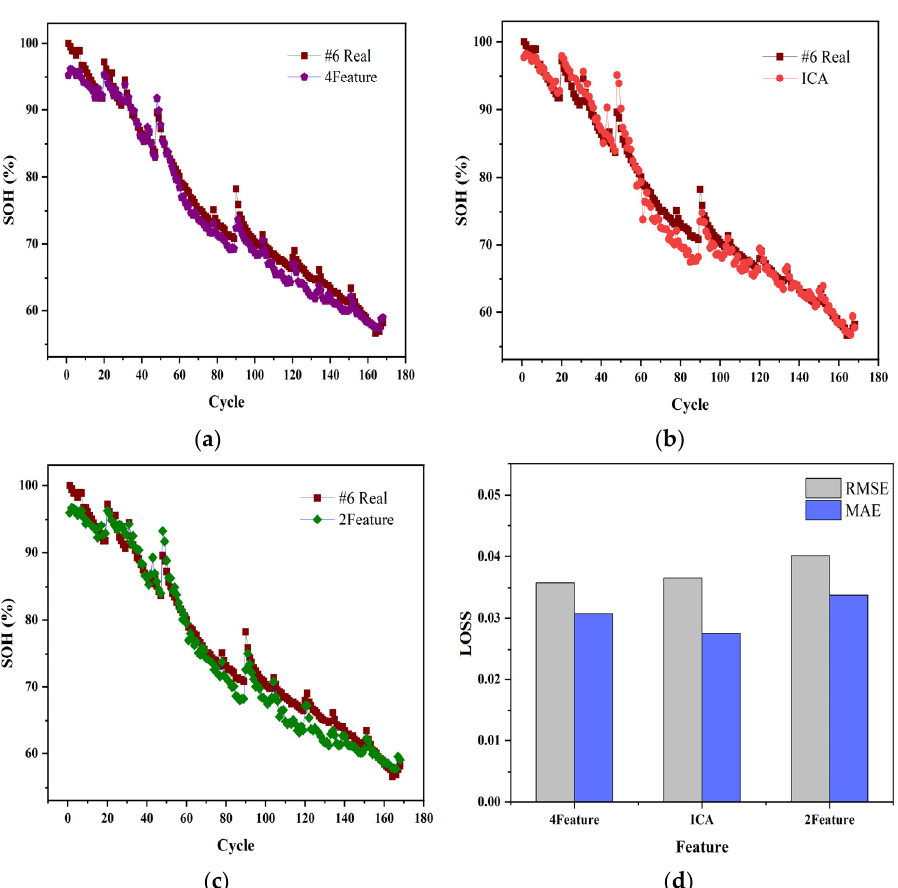
Figure 7. Transform learning for 6# battery ( a – c ). The predicted results of different features for 6# ( d ). The loss of battery 6#.